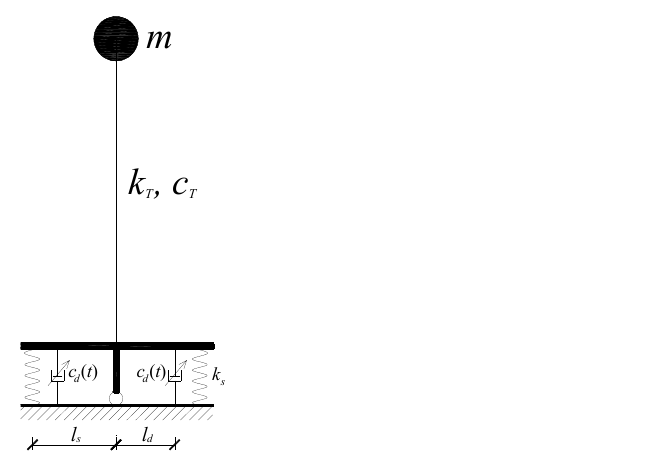
Figure 1. Smart base restraint including semi-active (SA) magnetorheological (MR) dampers: scheme of the idea.